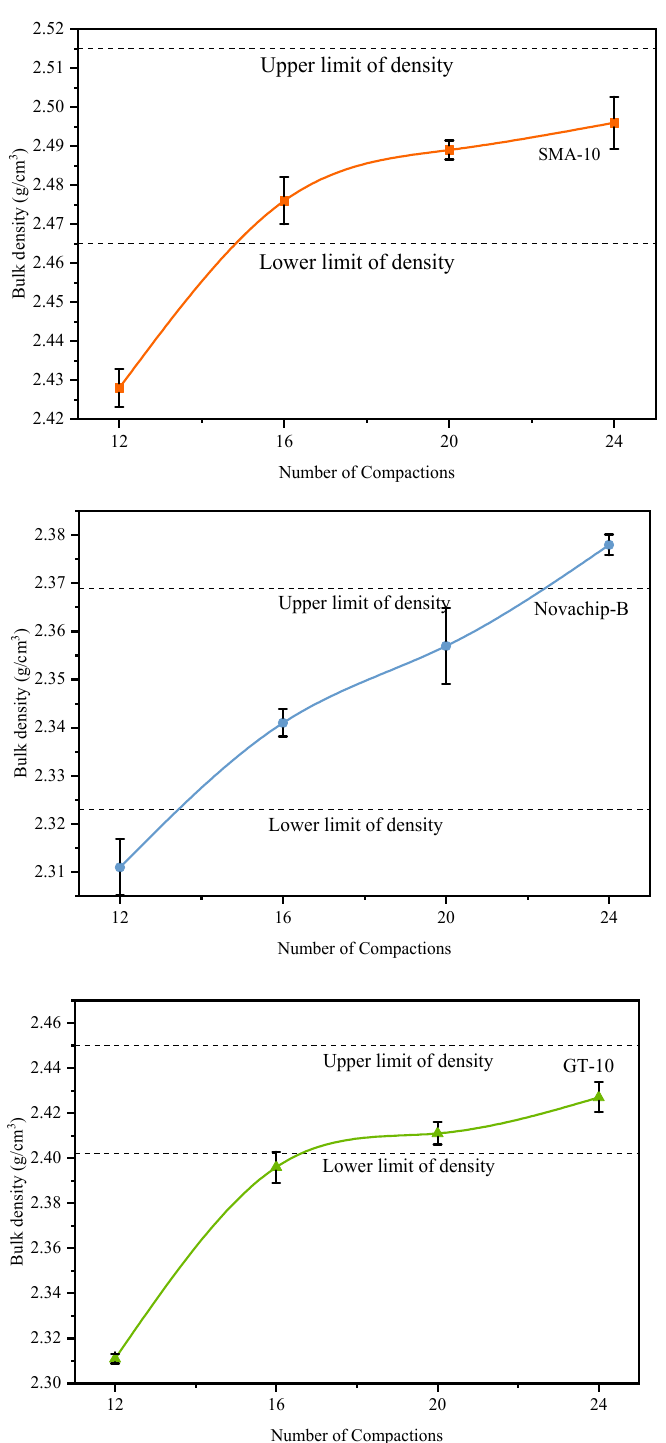
Figure 10. The bulk density of UTWC